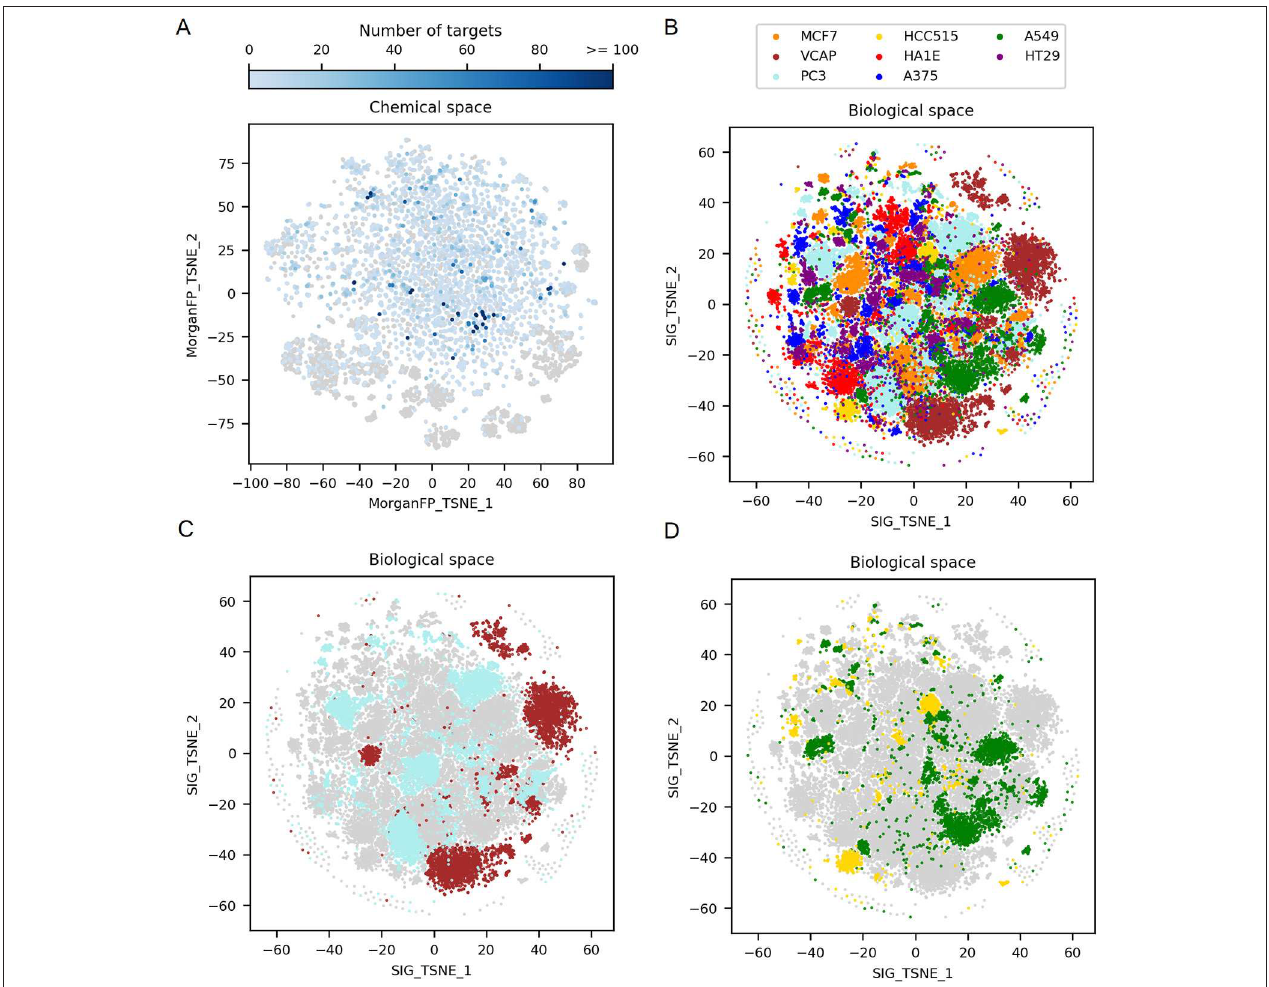
FIGURE 2 | Exploration of the 2D chemical space, along with the corresponding 2D biological space formed by all GES. (A) t-SNE on Morgan fingerprints from the 9,035 compounds in working dataset, representing the chemical space. Points corresponding to compounds for which there is no known target are represented by gray points ( n 4,163). Points corresponding to compounds for which there is at least one known target are in blue ( n = increasing number of targets. (B) t-SNE on all GESs in the working dataset, representing the biological (transcriptomic response) space. Points corresponding to GESs are colored by cell line. (C) Biological space highlighting only PC3 and VCAP signatures, 2 cell lines originating from prostate cancer. (D) Biological space highlighting only A549 and HCC515 signatures, 2 cell lines originating from lung